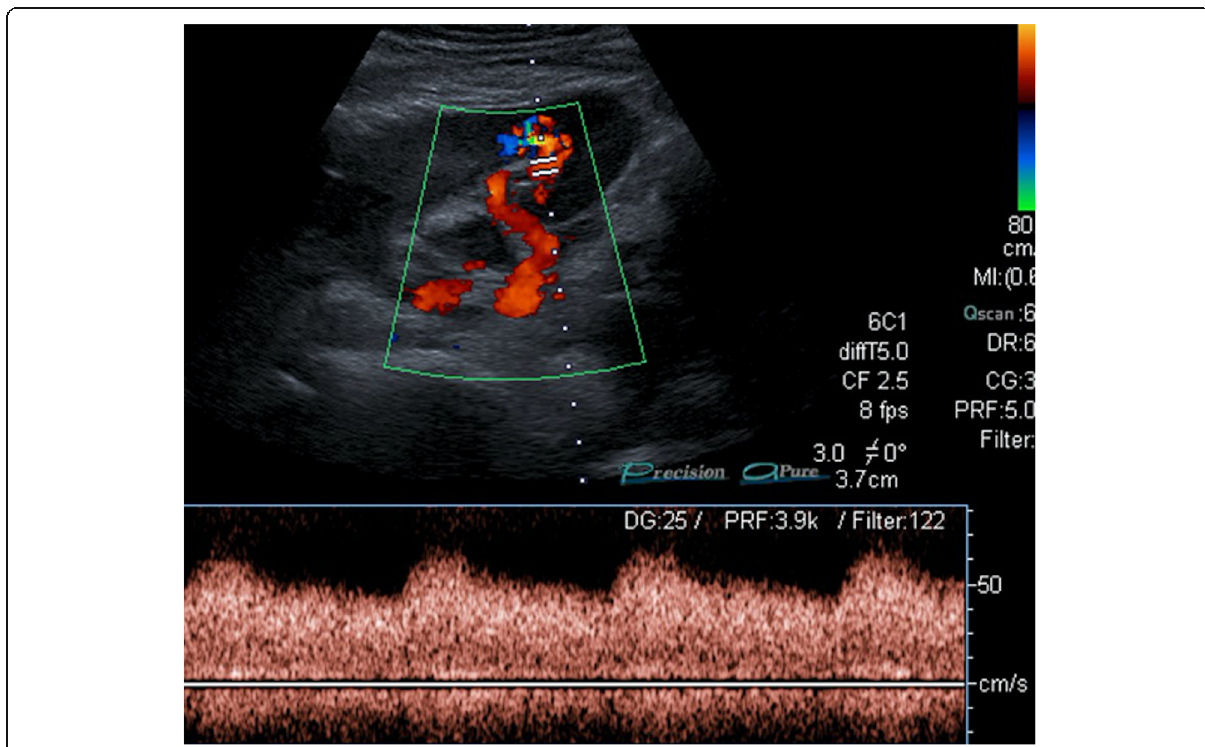
Fig. 15 Renal arteriovenous fistula. A 28-year-old female with a history of renal transplantation recently underwent percutaneous renal biopsy for suspected graft rejection. The patient experienced hematuria the day after the biopsy. Doppler US evaluation of the graft kidney demonstrates aliasing in the lower pole parenchyma suggestive for high velocity disturbed flow. The flow waveform was also suggestive for arterialized venous flow with reduced systolic-diastolic difference. The patient underwent CO 2 angiogram with subsequent successful coil